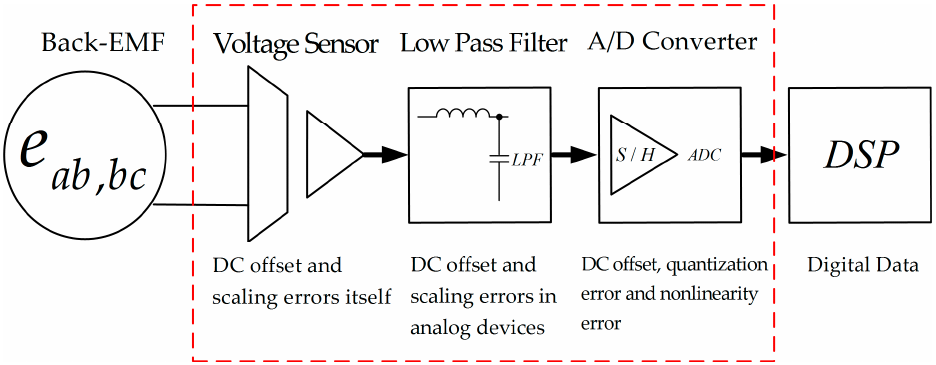
Figure 4. The back-EMF measurement path.